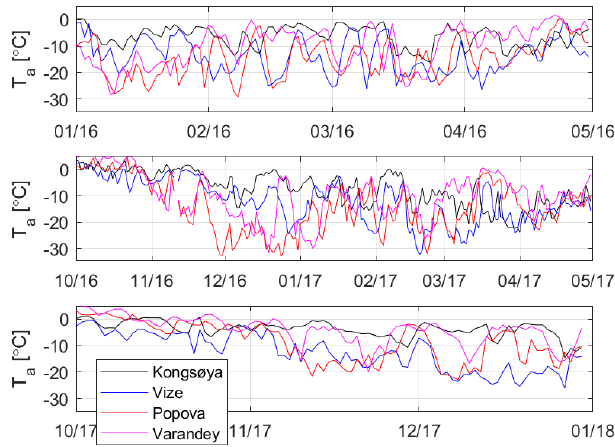
Figure 3. Average daily air temperature during the period 2016– 2017 from four coastal weather stations shown in Fig.